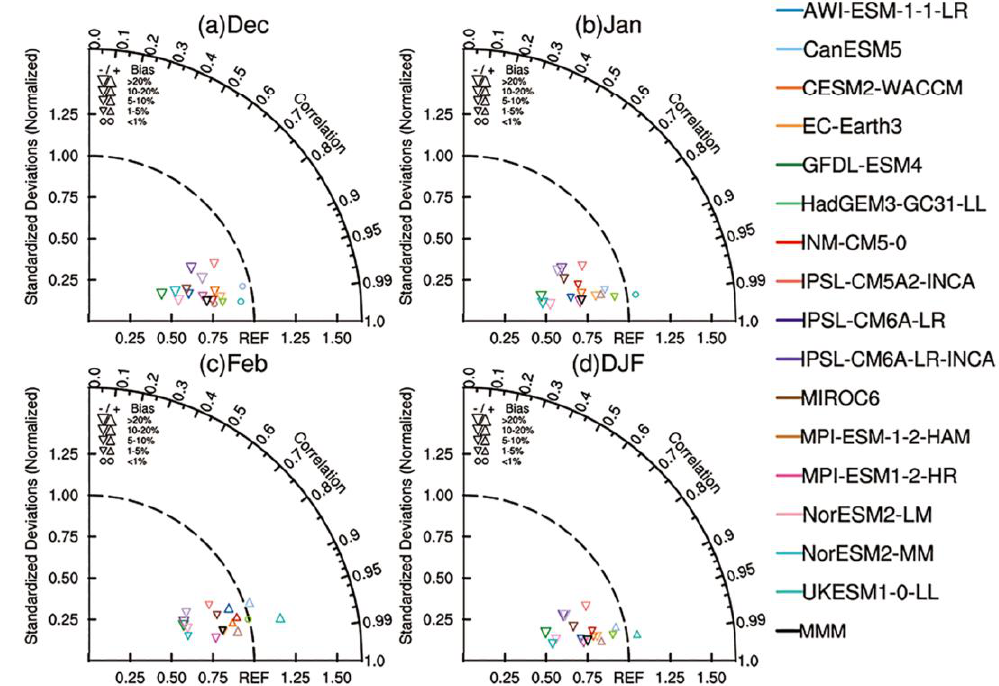
Figure 4. Taylor diagram for climatological mean of PV simulated by 16 CMIP6 models. These simulations are compared with MERRA2 over polar cap (60 ◦ –90 ◦ N). All data are averaged over the isentropic levels between 430–600 K for the period of 1980/81–2013/14 in each winter month ( a – c ) and for DJF mean ( d ). In Taylor diagram, the angular axis shows spatial correlation between simulated and observed climatology of PV, the radial axis shows spatial SD normalized against that of the MERRA2 , “REF” represents the reference line. More details can be found in Taylor (2001) [63]. Different symbols denote different percentage biases between MERRA2 and model simulations. Each symbol represents an individual CMIP6 model.